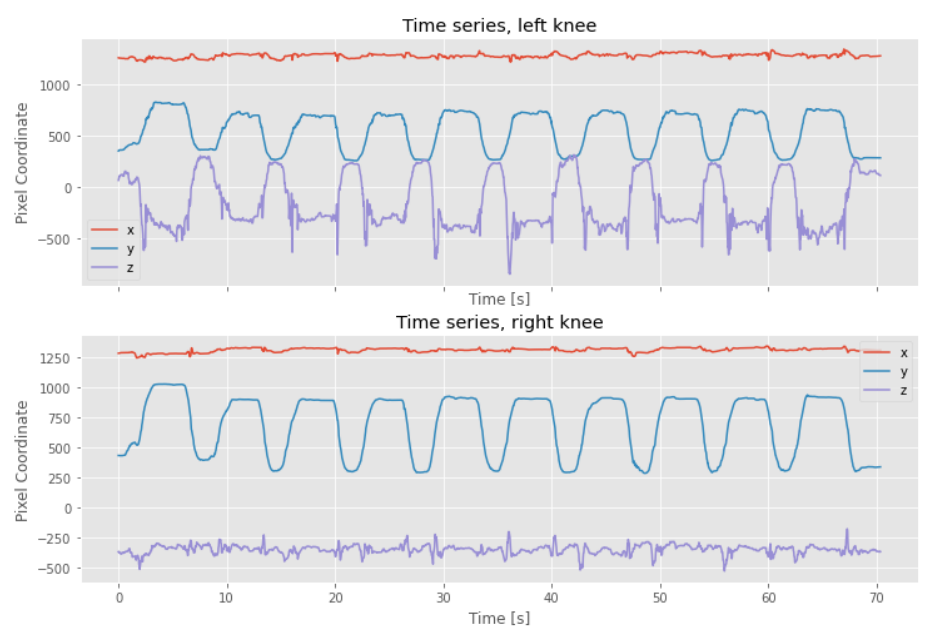
Figure A1. Sample keypoint time series from one video of a subject performing flexion in lying. The top plot shows the x , y and z coordinates of the left knee over the course of the video, estimated by BlazePose. The right knee is shown in the bottom